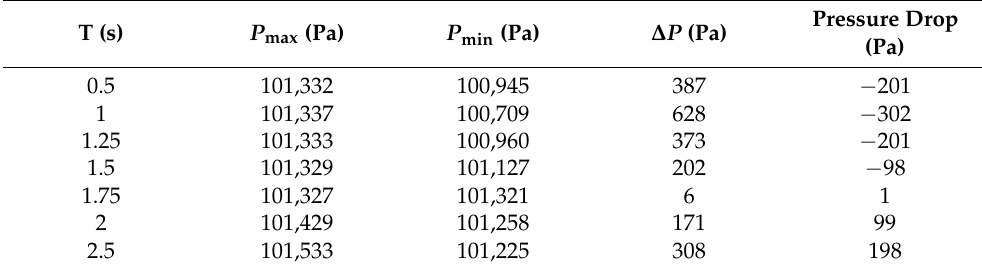
Table 2. The change of the cavity pressure of the OSAHS patient under eupnea.